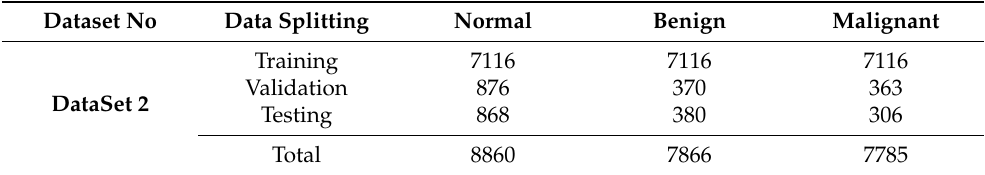
Table 4. Splitting based on the patient level to create (256 × 256) patches using augmentation for normal, benign, and malignant